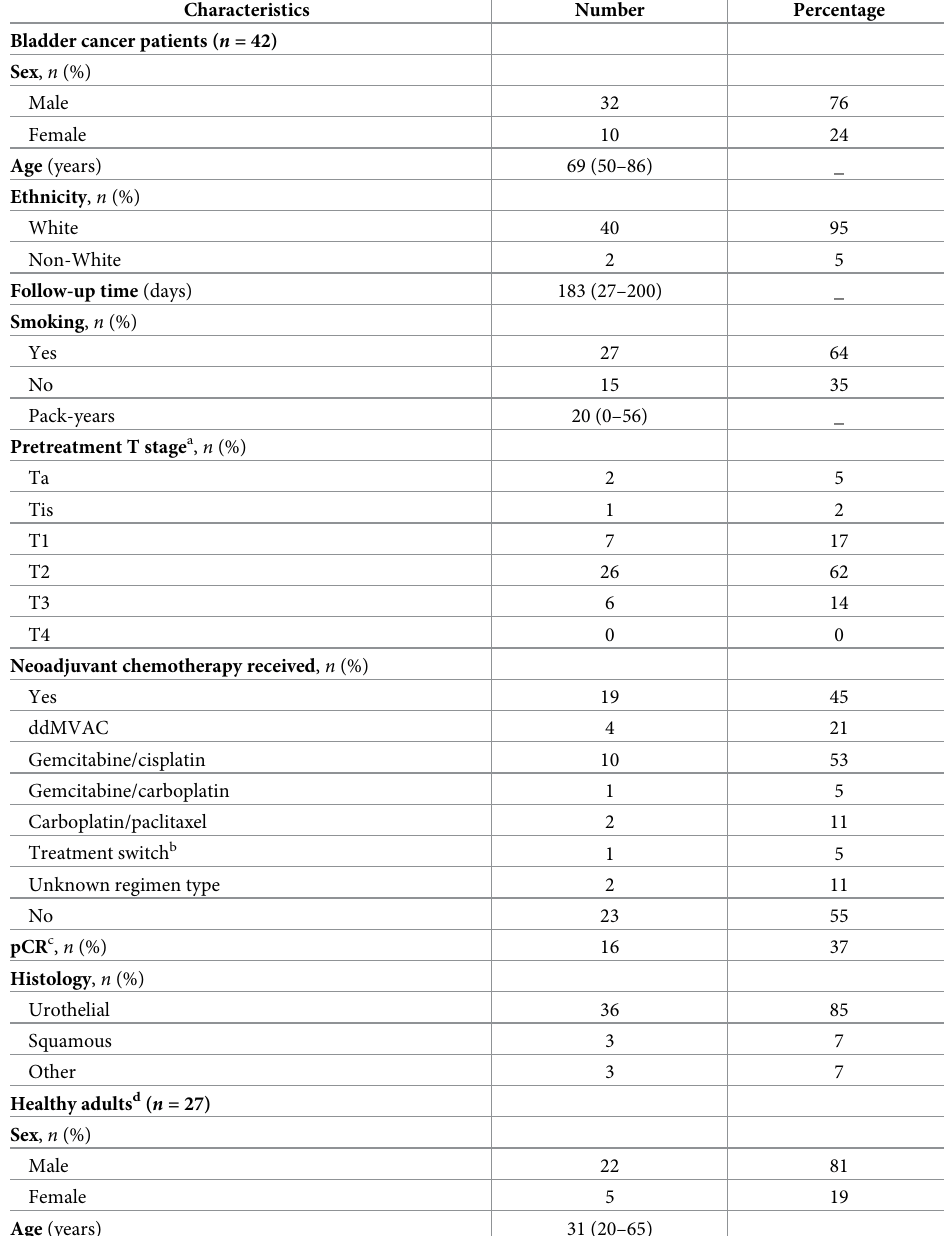
Table 1. Characteristics of enrolled bladder cancer patients and healthy adults.